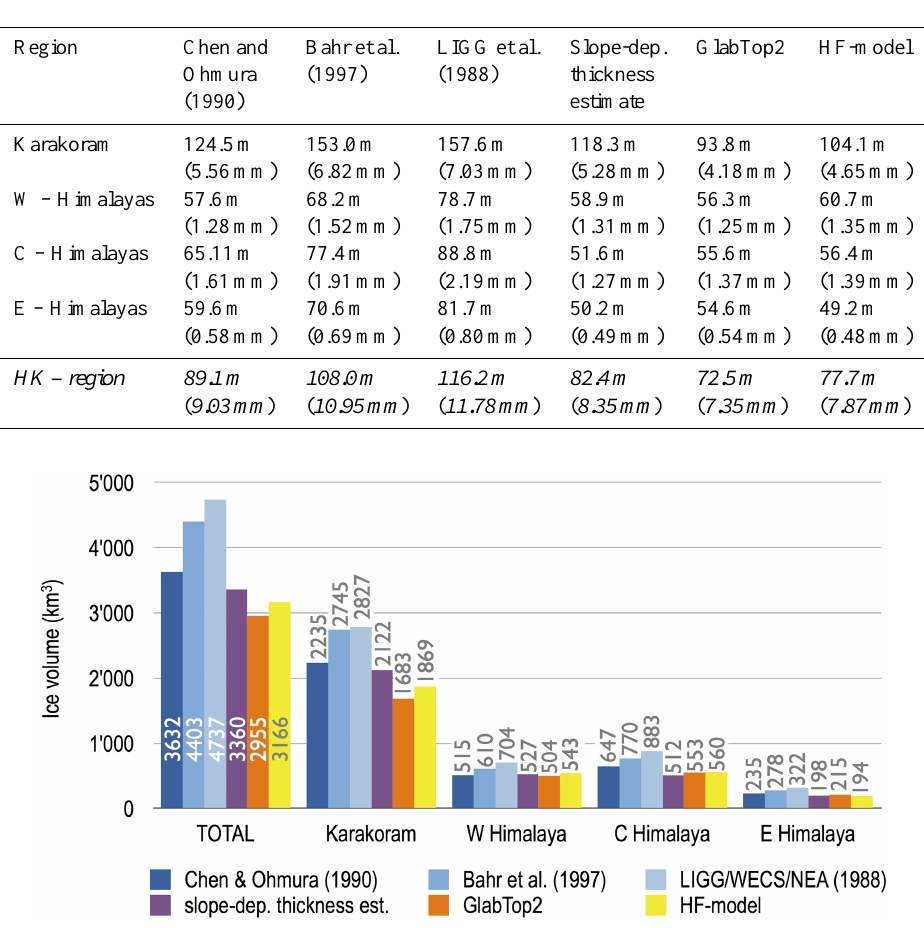
Table 3. Mean ice thicknesses and corresponding sea level equivalents (SLE) in brackets. See Fig. 5 for ice volumes.